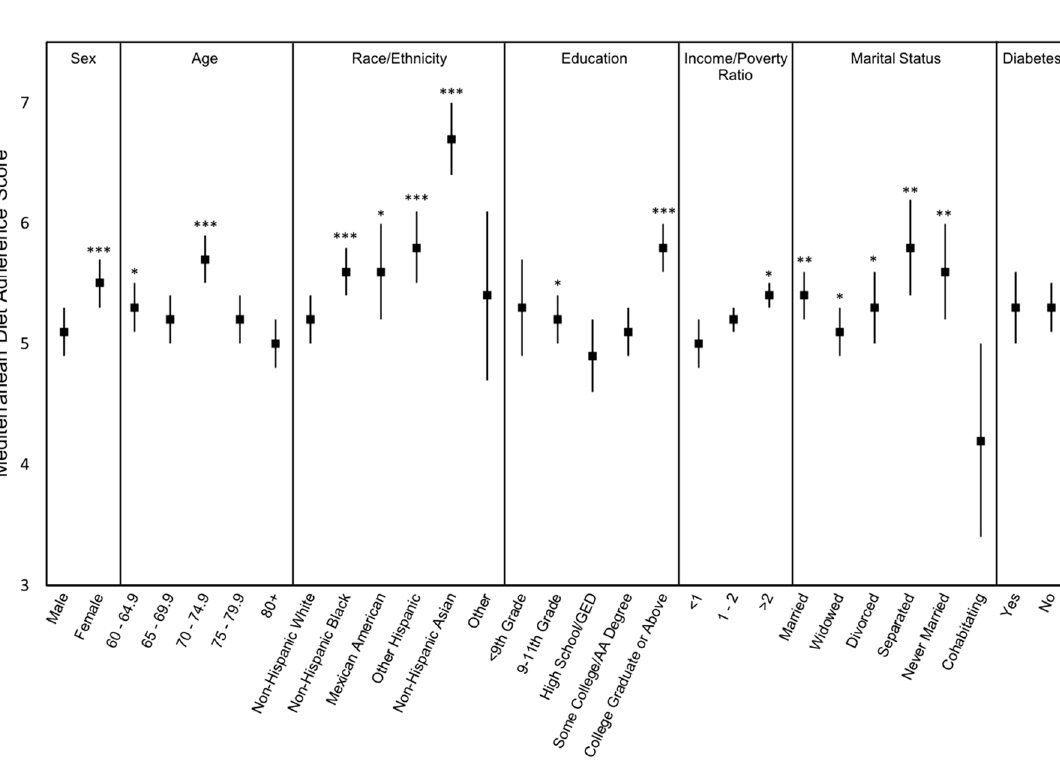
Figure 2. Mediterranean Diet adherence mean scores and 95% confidence intervals of older adults in the US by demographic characteristic. Sex: male ( n = 1509), female ( n = 1559); Age: 60–64.9 ( n = 930), 65–69.9 ( n = 675), 70–74.9 ( n = 551), 75–79.9 ( n = 361), 80 + ( n = 551); Race: Non-Hispanic White ( n = 1463), Non-Hispanic Black ( n = 740), Mexican American ( n = 273), Other Hispanic ( n = 301), Non-Hispanic Asian ( n = 242), Other Race ( n = 49); Education: < 9th Grade ( n = 412), 9-11th Grade ( n = 447), High School / GED ( n = 708), Some College / AA Degree ( n = 830), College Graduate or Above ( n = 667); Income to Poverty Ratio: < 1 ( n = 526), 1–2 ( n = 838), > 2 ( n = 1458); Marital Status: Married ( n = 1660), Widowed ( n = 632), Divorced ( n = 425), Separated ( n = 82), Never Married ( n = 187), Cohabitating ( n = 79); Diabetes Status: Yes ( n = 741), No ( n = 2337). Analyses were survey-weighted ordinary least squares regression models using Tukey’s HSD for multiple pairwise comparisons. Models were not adjusted for covariates. p -values based on mean difference from the lowest mean value of each demographic category. * p < 0.05, ** p < 0.01, *** p < 0001.